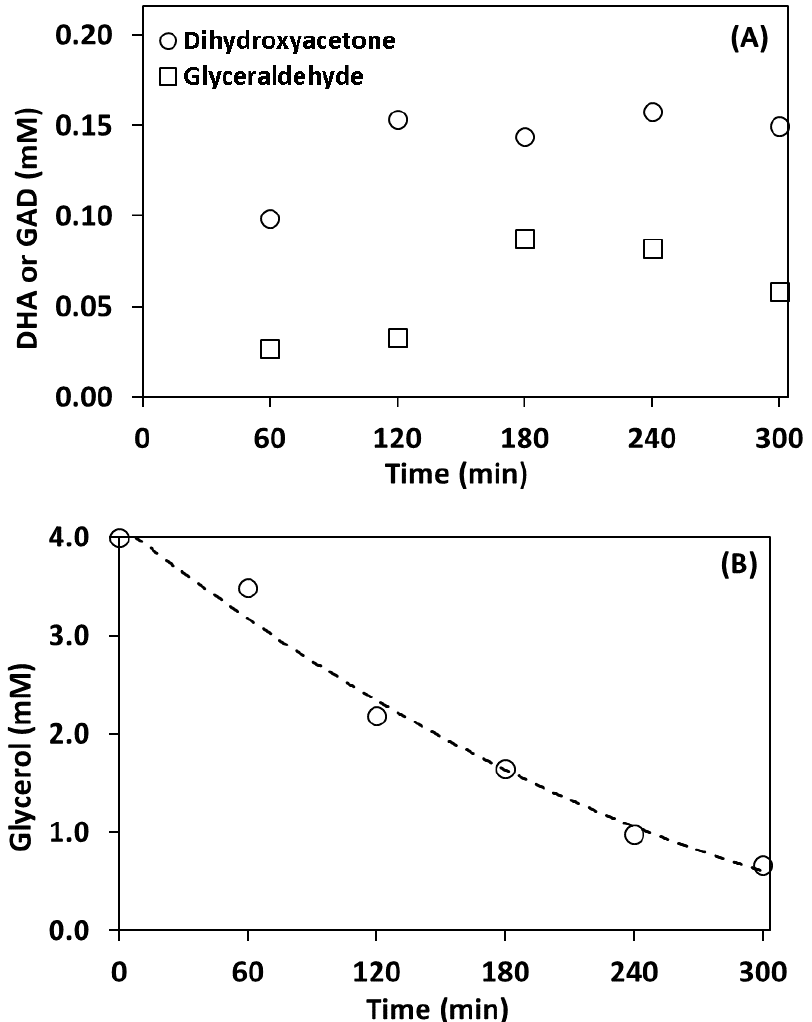
Figure 1. Photocatalytic reaction of glycerol in ethyl acetate under simulated solar light. ( A ) The concentration of dihydroxyacetone (DHA) and glyceraldehyde (GAD), and ( B ) concentration of glycerol over time. Ethyl acetate: 100 mL, glycerol: 0.4 mmol, Degussa P25 TiO 2 : 0.1 g.